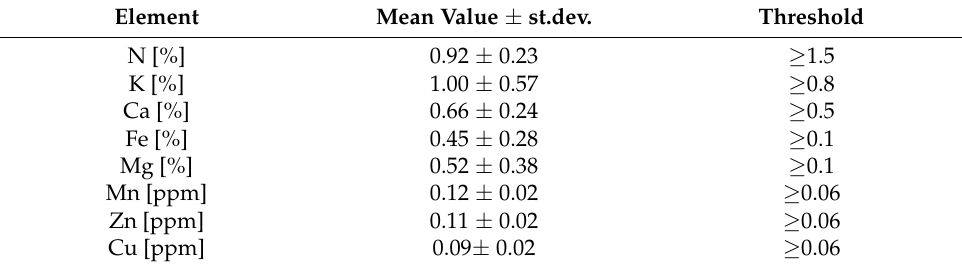
With regard to the crop nutritional status, of the nine elements determined by the leaf samples to assess nutrient deficiencies (Table 3), only nitrogen had a concentration below the threshold [4,17,36]. Indeed, the total N concentration of plant leaves ranged from 0.40% to 1.46%, being on average 0.92% (Figure 3).